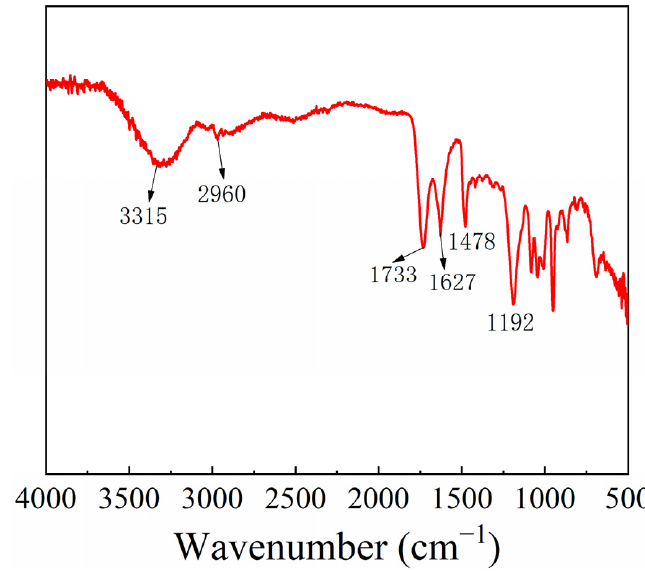
Figure 6. The FT-IR spectra of AMP.